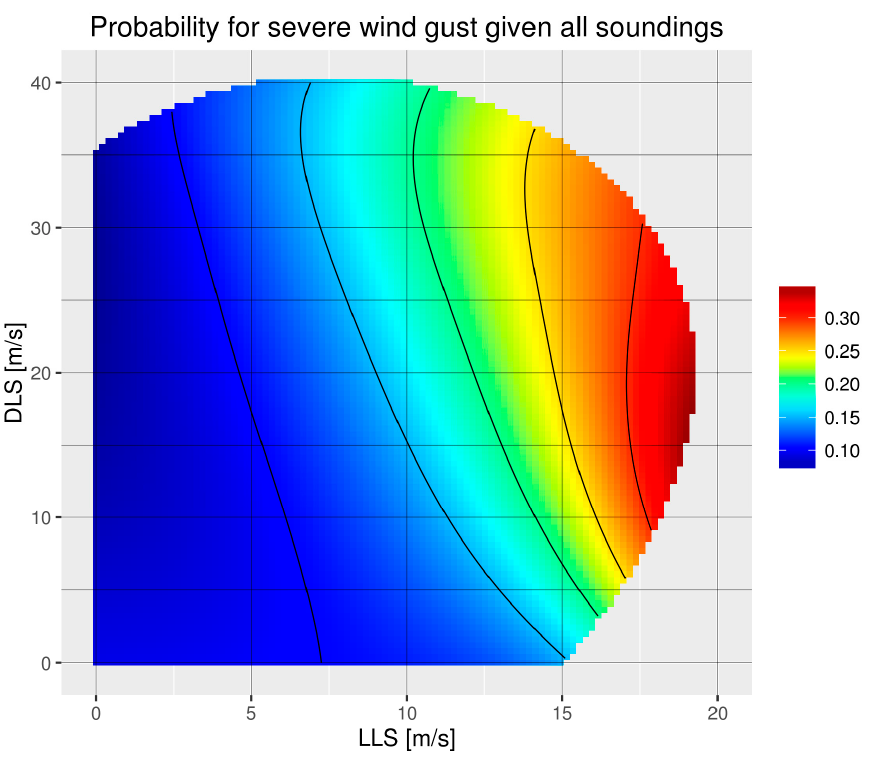
Figure 12. As in Figure 9, except for the severe wind.